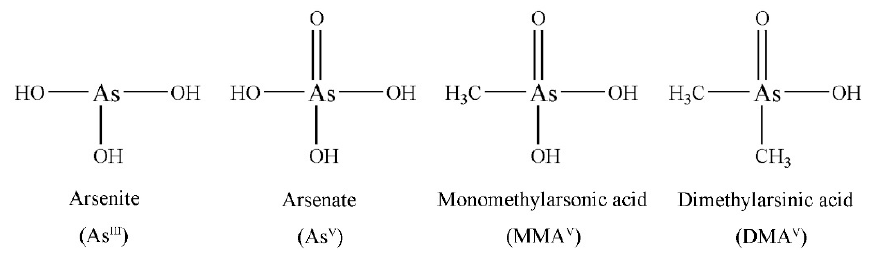
Figure 1. Chemical structures of the four arsenic species.